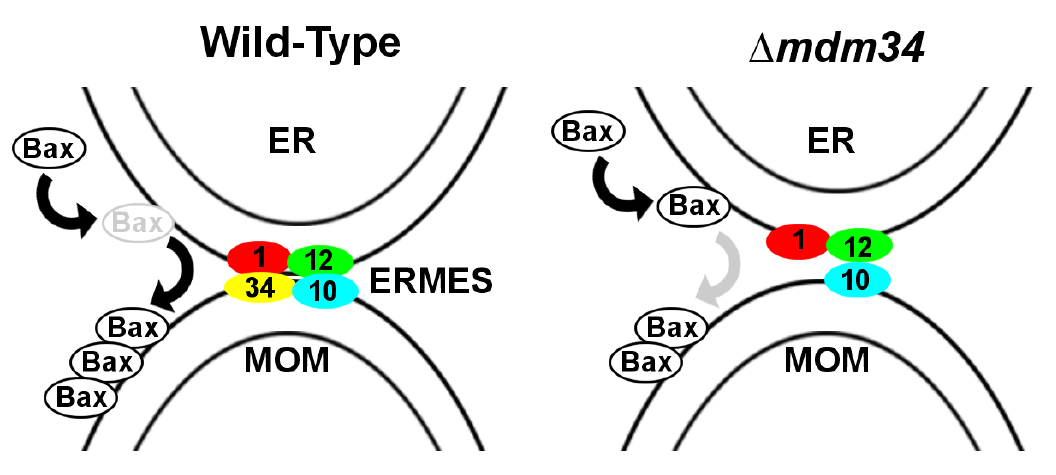
FIGURE 5: Hypothetical pathway of Bax relocation. In wild-type cells, Bax would transit through the ER before reaching the OMM through ERMES-stabilized contacts. The deletion of MDM34 would destabilize the contacts and decrease the rate of transfer to OMM, thus induc- ing an increase of the accumulation in the ER. We speculate that the complete loss of contacts through the deletion of other ERMES com- ponents would fully impair Bax mitochondrial